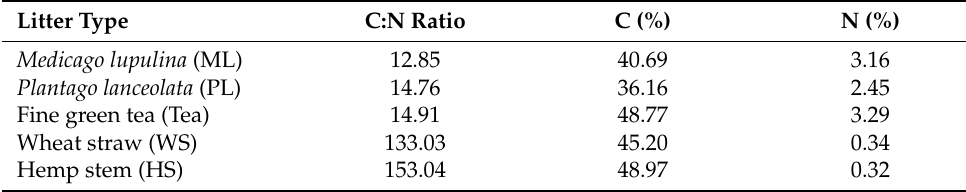
Table 1. The C and N content, and C:N ratios of organic